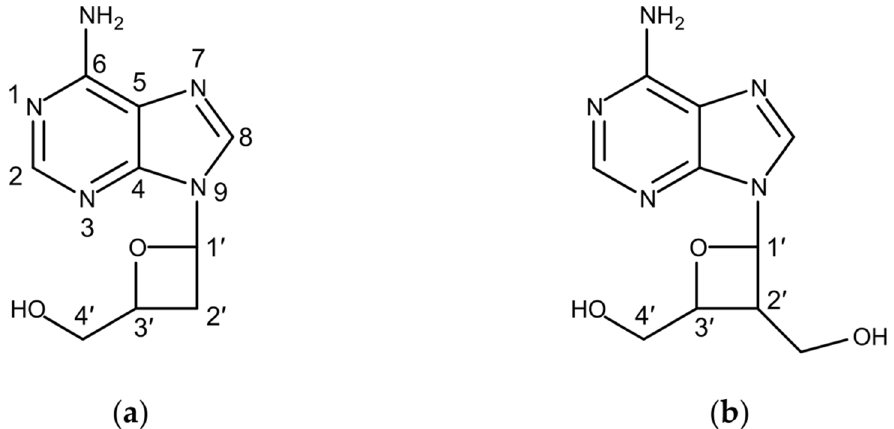
Figure 2. The structures of ( a ) albucidin and ( b ) oxetanocin A.